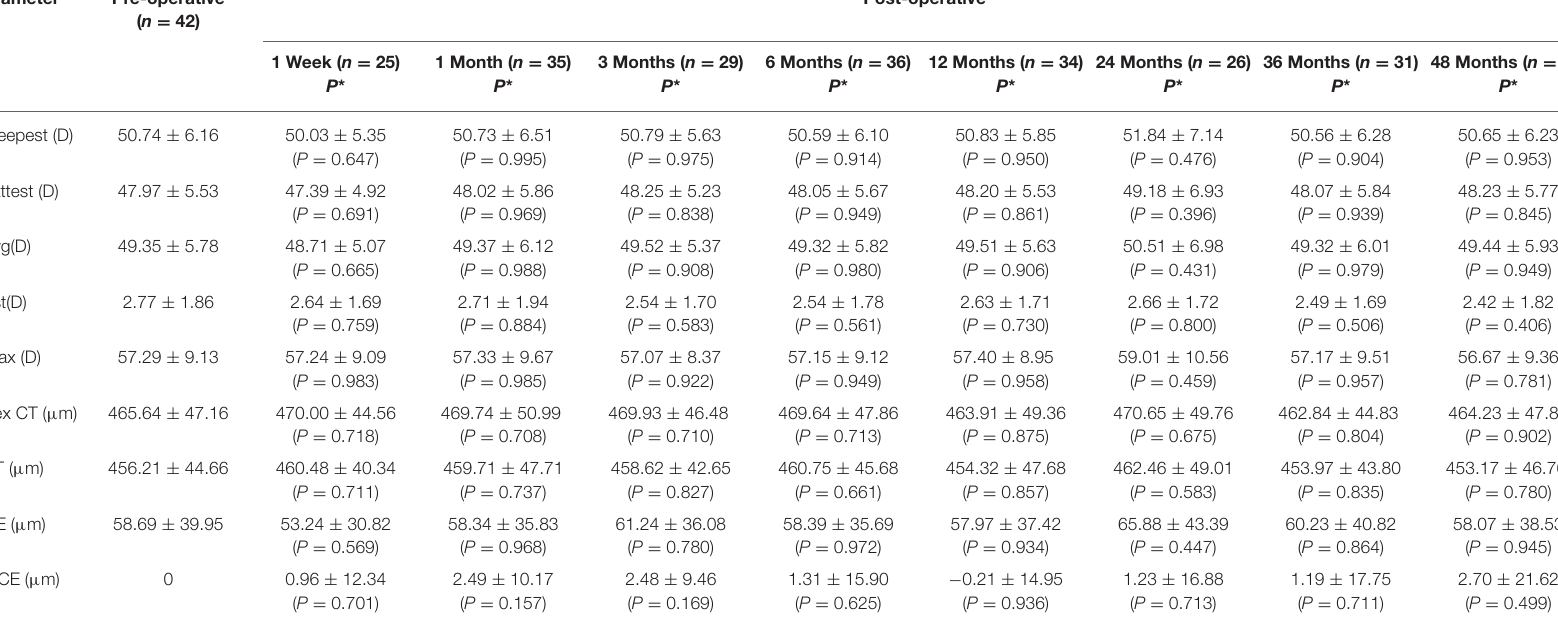
TABLE 2 | Topography parameters, pre-operative and 1 Week, 1, 3, 6, 12, 24, 36, and 48 months post-operatively.